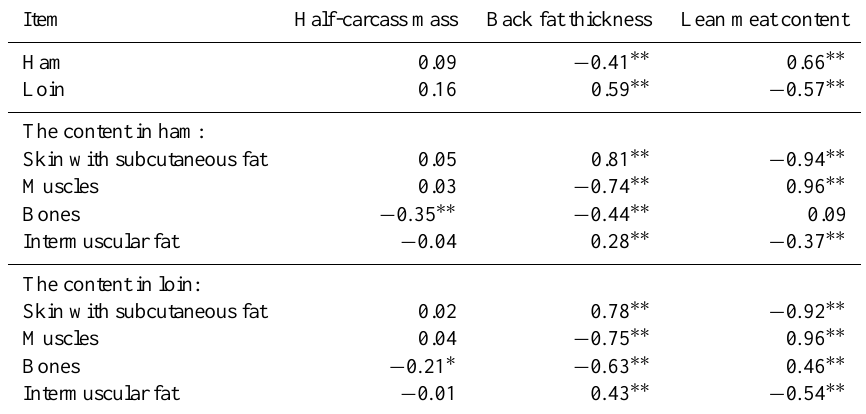
Table 4. The Pearson’s correlation between the half-carcass mass, back fat thickness and lean meat content for the studied parameters.